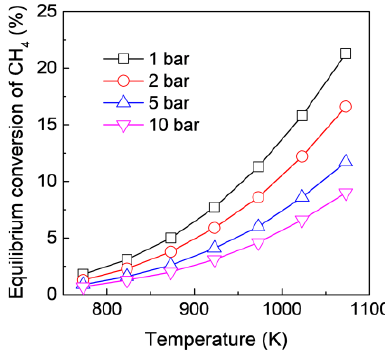
Figure 2. Equilibrium conversion of CH 4 in MDA under different temperatures and pressures.